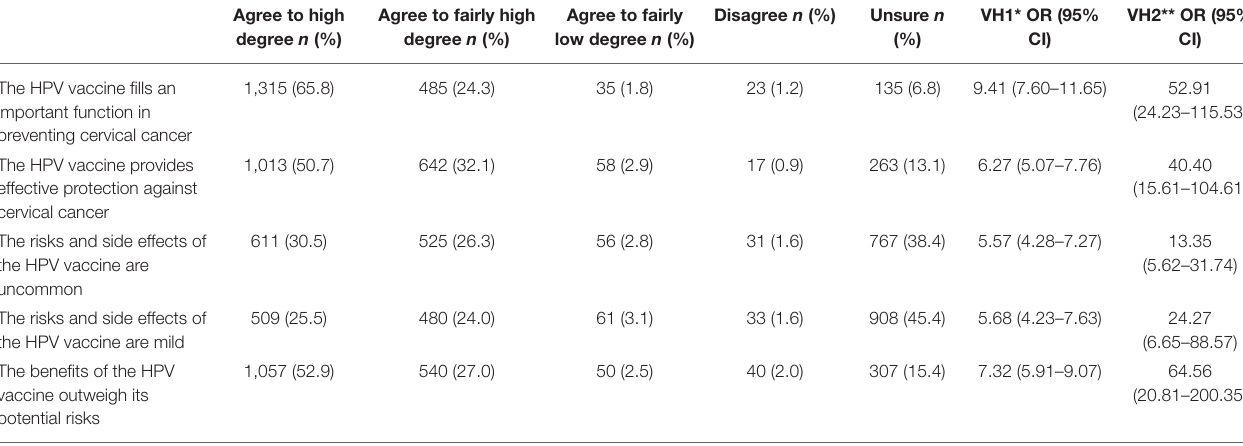
TABLE 3 | Perceived risks and benefits of the HPV vaccine, and associations between HPV vaccine hesitancy (VH1; VH2) and less or no agreement with the respective statements, measured through logistic regressions and expressed as odds ratios (ORs) with 95% confidence intervals (CIs). Agree to high Agree to fairly high Agree to fairly Disagree n (%) Unsure n VH1* OR (95% VH2** OR (95% degree n (%) degree n (%) low degree n (%) (%) CI) CI)